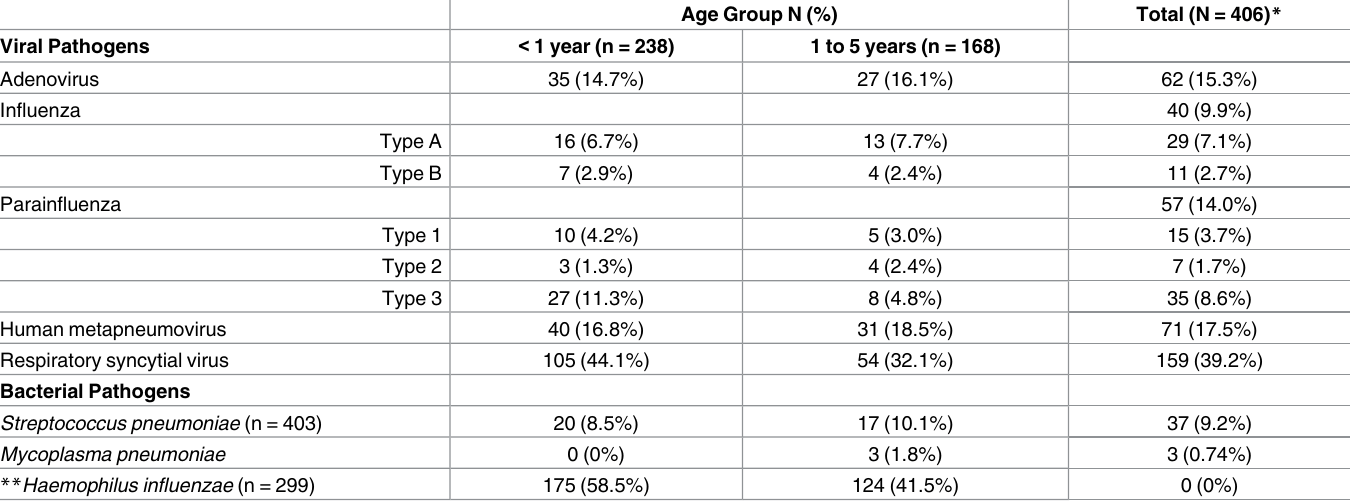
Table 2. Pneumonia etiology by age